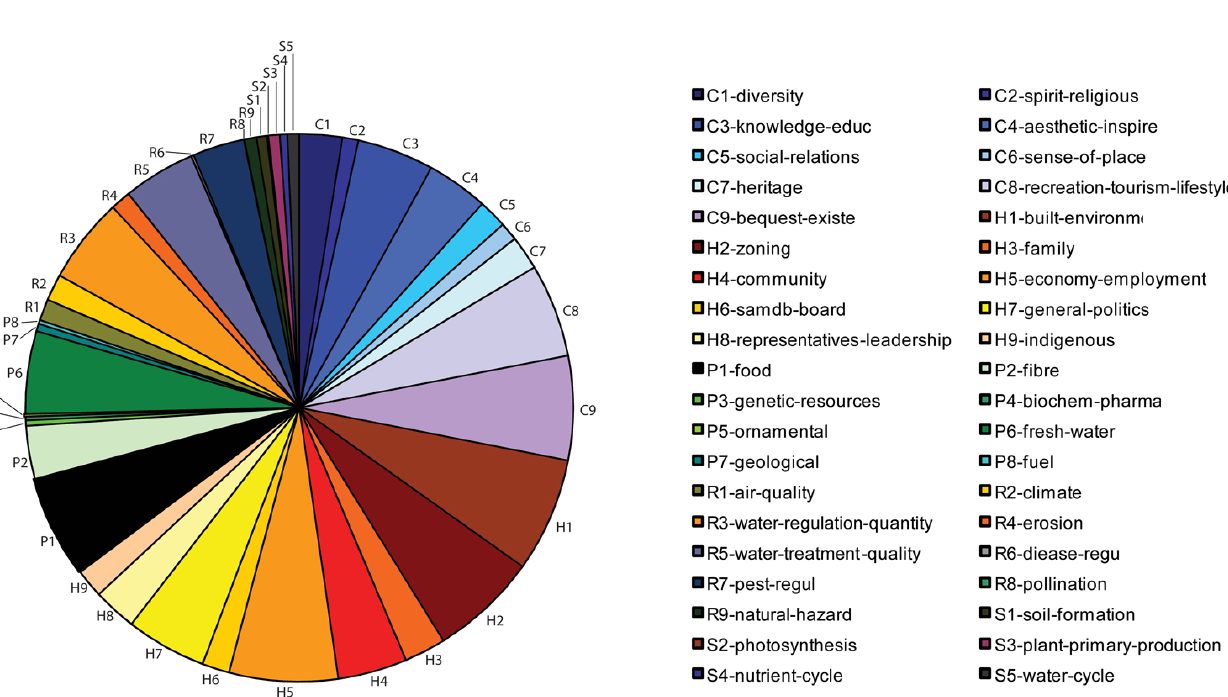
Fig. 3 . Code frequency of different